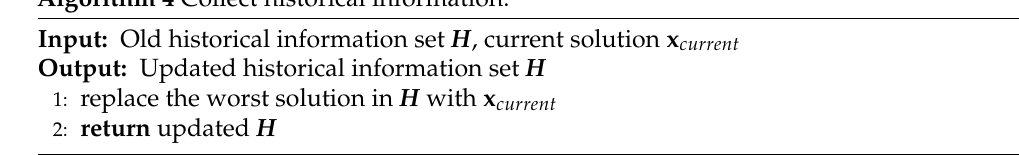
Algorithm 4 Collect historical